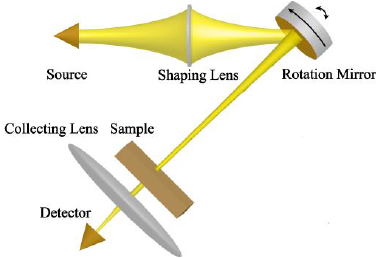
Figure 1. Schematic diagram of the THz rotation mirror imaging system.